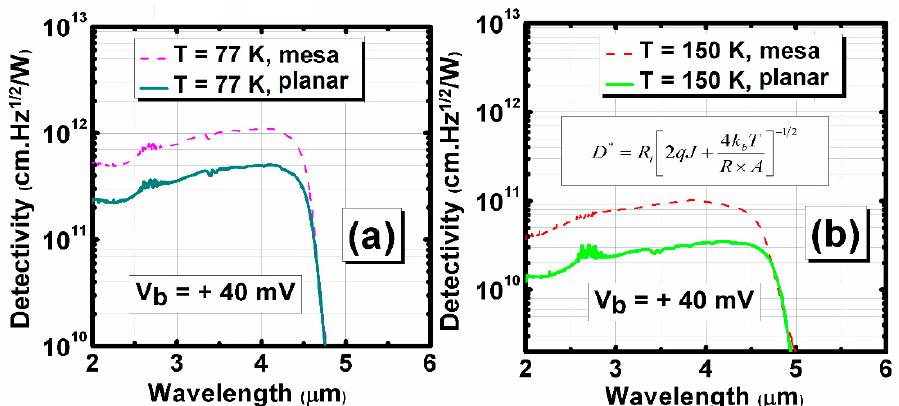
Figure 5. ( a ) Specific detectivity (D*) spectrum for the optimized planar (I Eng = 300 KeV and Idose = 1.0 × 10 15 cm − 2 ) and mesa-isolated MWIR T2SL photodetectors at ( a ) 77 K and ( b ) 150 K. Calculation is